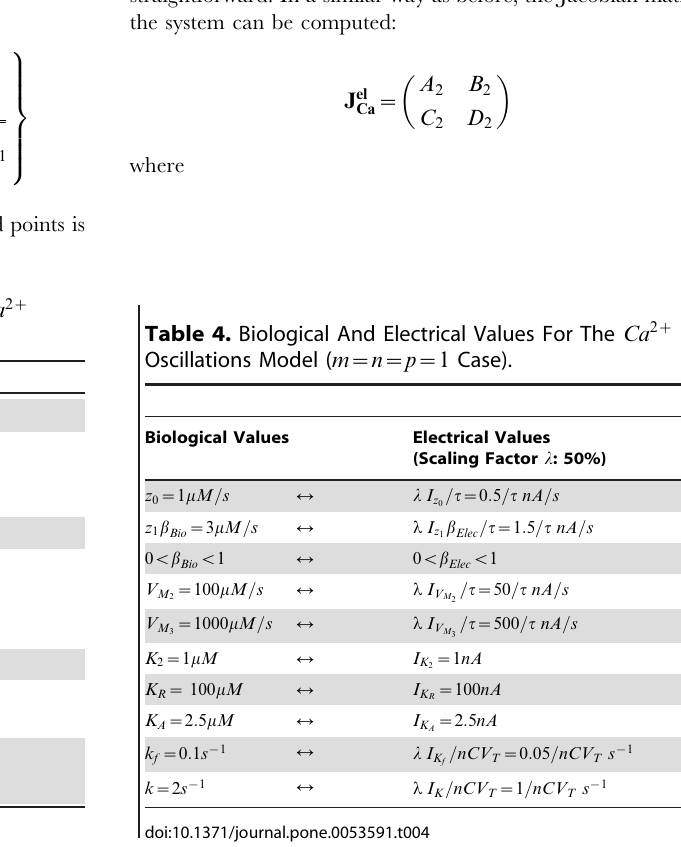
Figure 8. Regions of oscillations (shaded parts) for both prototype and electrical intracellular Ca 2 + oscillations systems, based on their traces illustrated in Table 3. A relation between K R and (cid:2) ZZ = k and I K values been used for the calculation of both areas are shown in Tables 5 and 9.